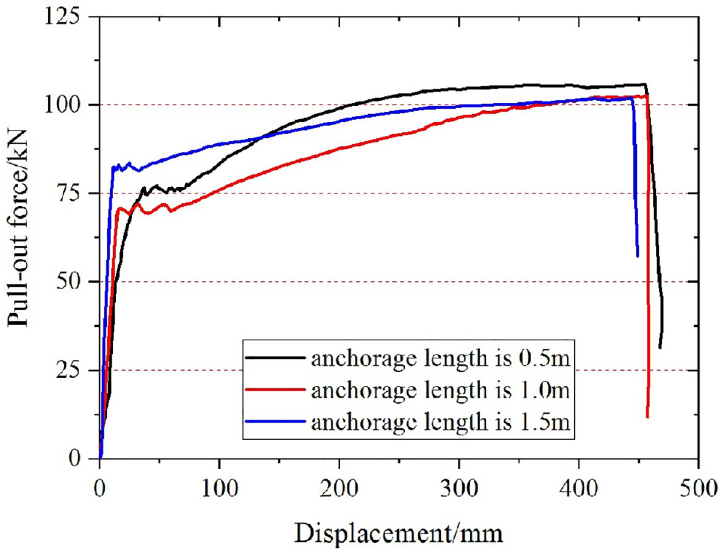
Fig 6. Relationship between pull-out force and displacement of bolt with different anchorage